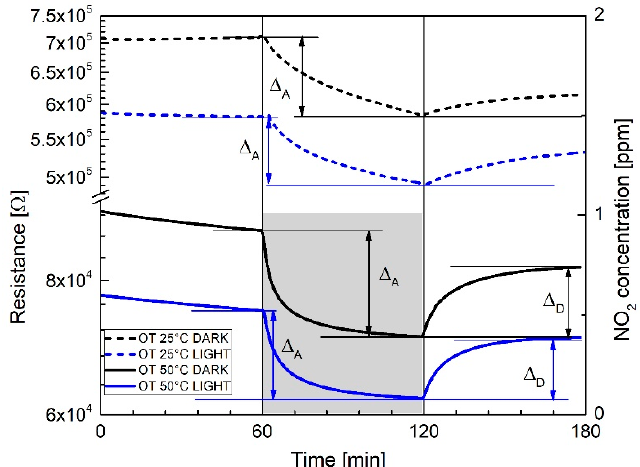
Figure 7. The 1 ppm NO 2 gas responses of the WS 2 -decorated rGO under “dark” and “light” conditions (dotted lines) at 25 °C operating temperatures compared to the “dark” and light” conditions (solid lines) at 50 °C operating temperature.